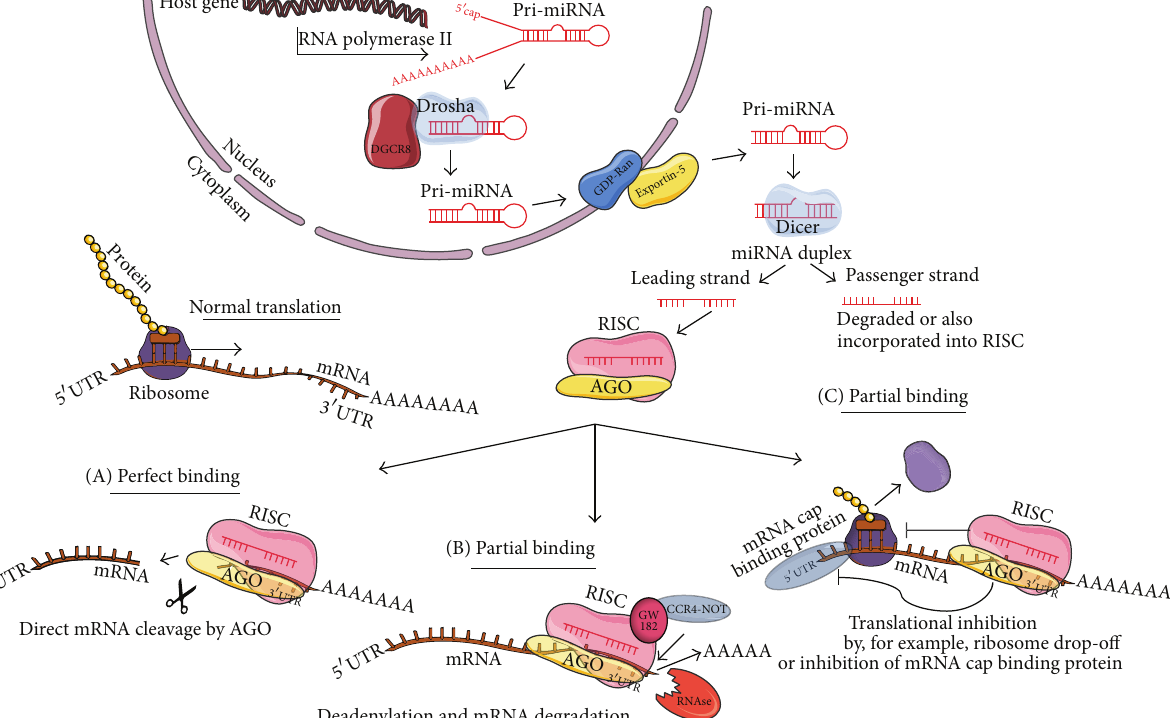
Figure1:miRNAbiogenesis.miRNAsaretranscribedasmRNAtranscriptsfromthegenomebypolymeraseIIaspre-miRs.Endoribonuclease